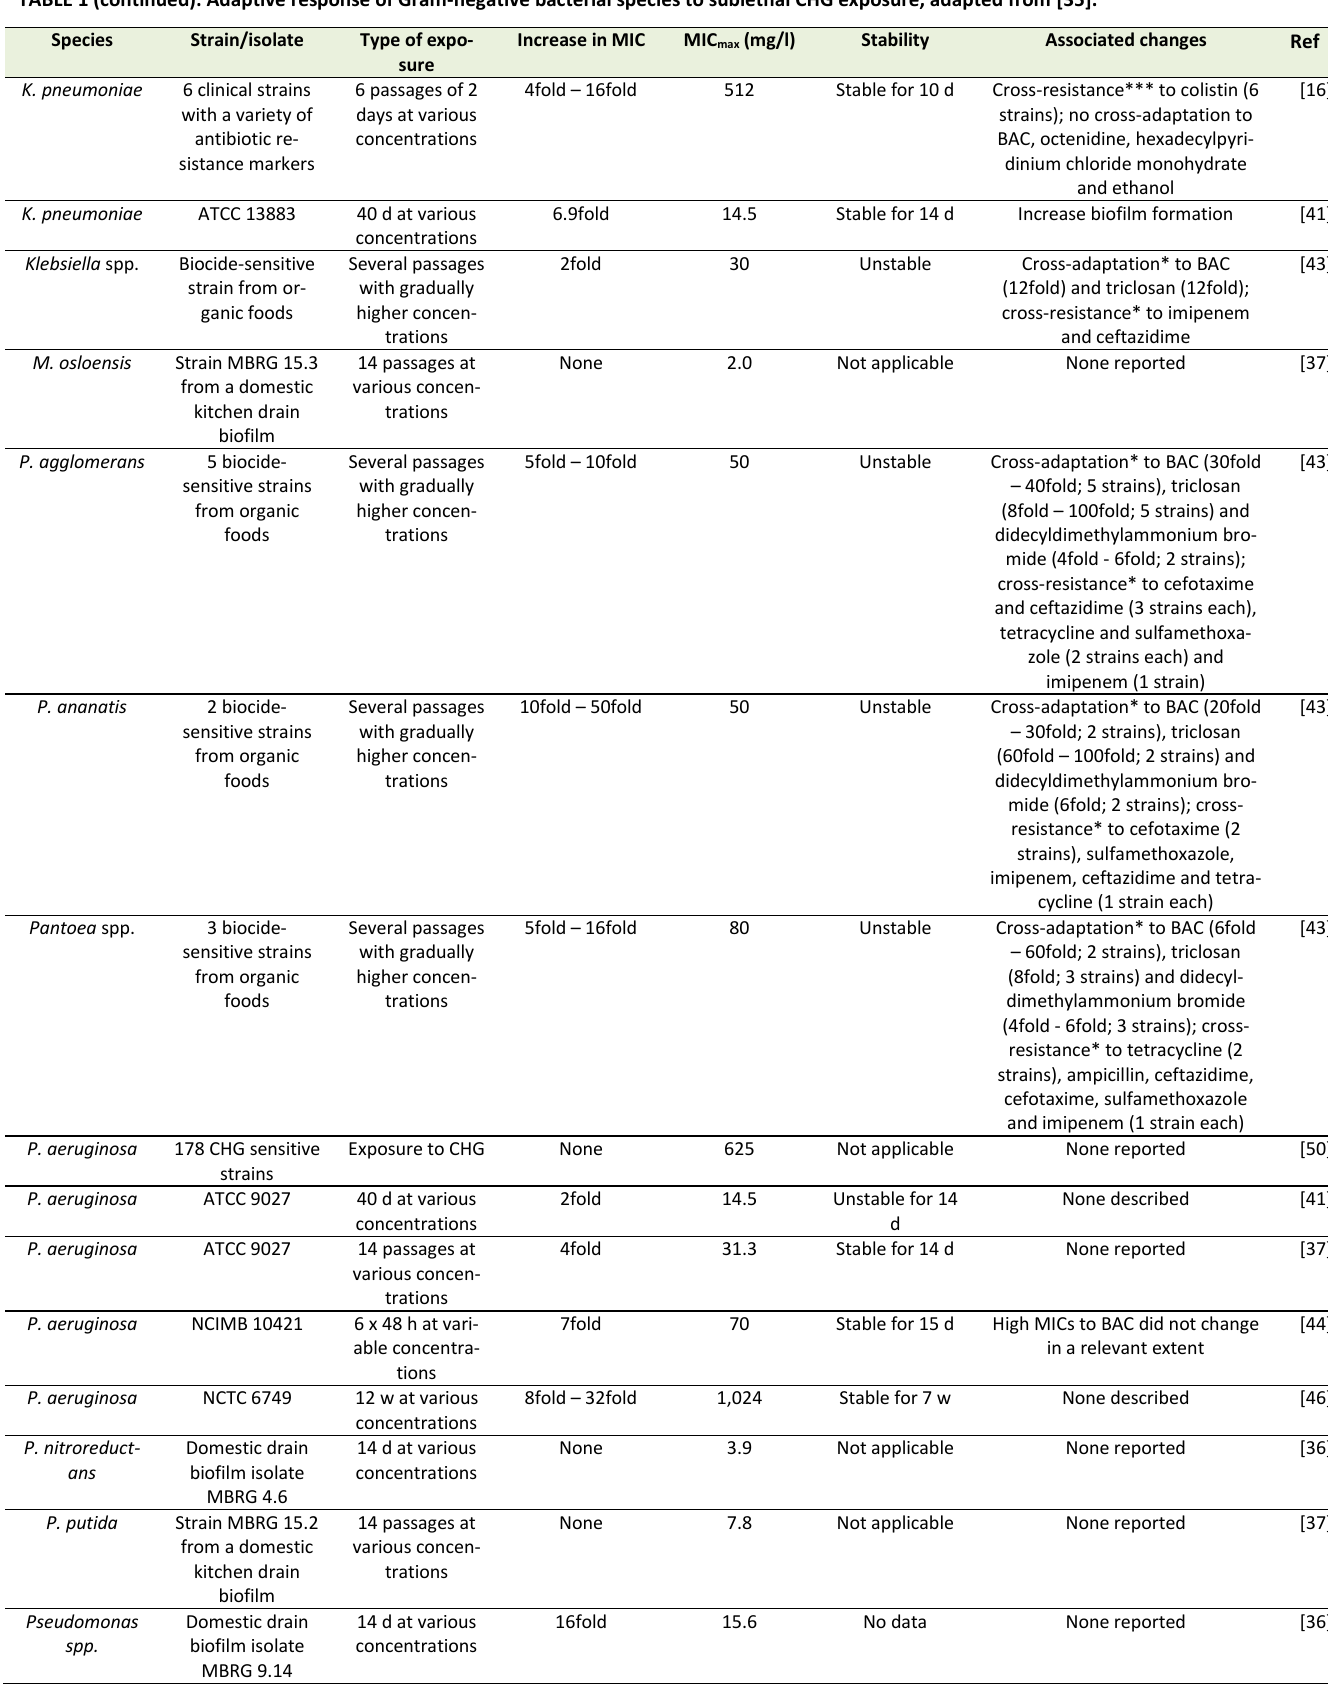
TABLE 1 (continued): Adaptive response of Gram-negative bacterial species to sublethal CHG exposure, adapted from